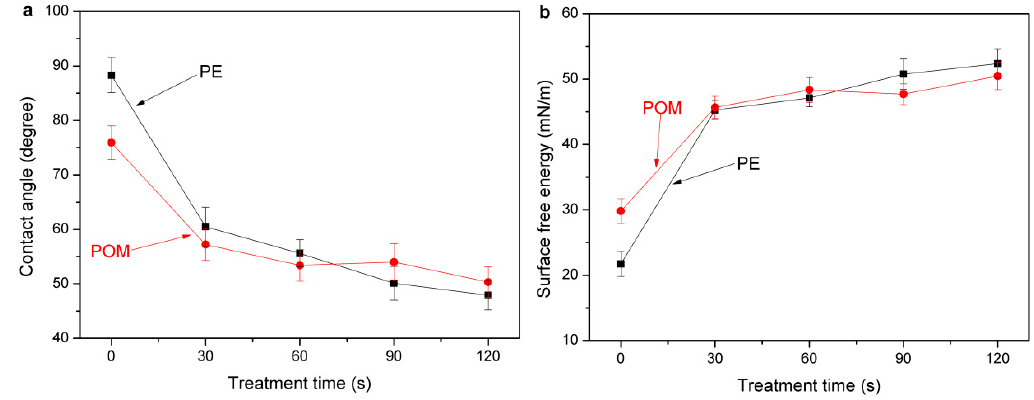
Figure 5. Variation in surface contact angles ( a ) and surface free energy ( b ) of PE and